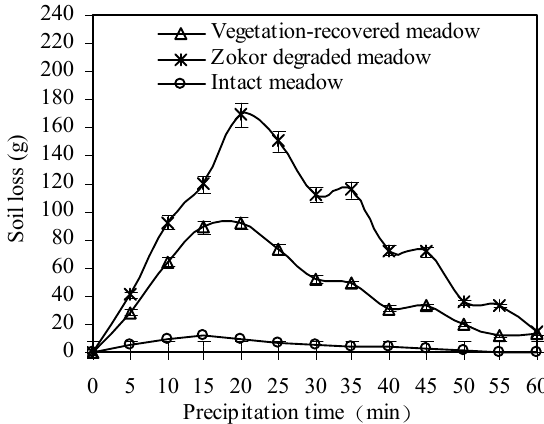
Figure 10. Comparison of soil loss from three types of surface covers. Results are based on a rainfall intensity of 10 mm h − 1 on 20 ◦